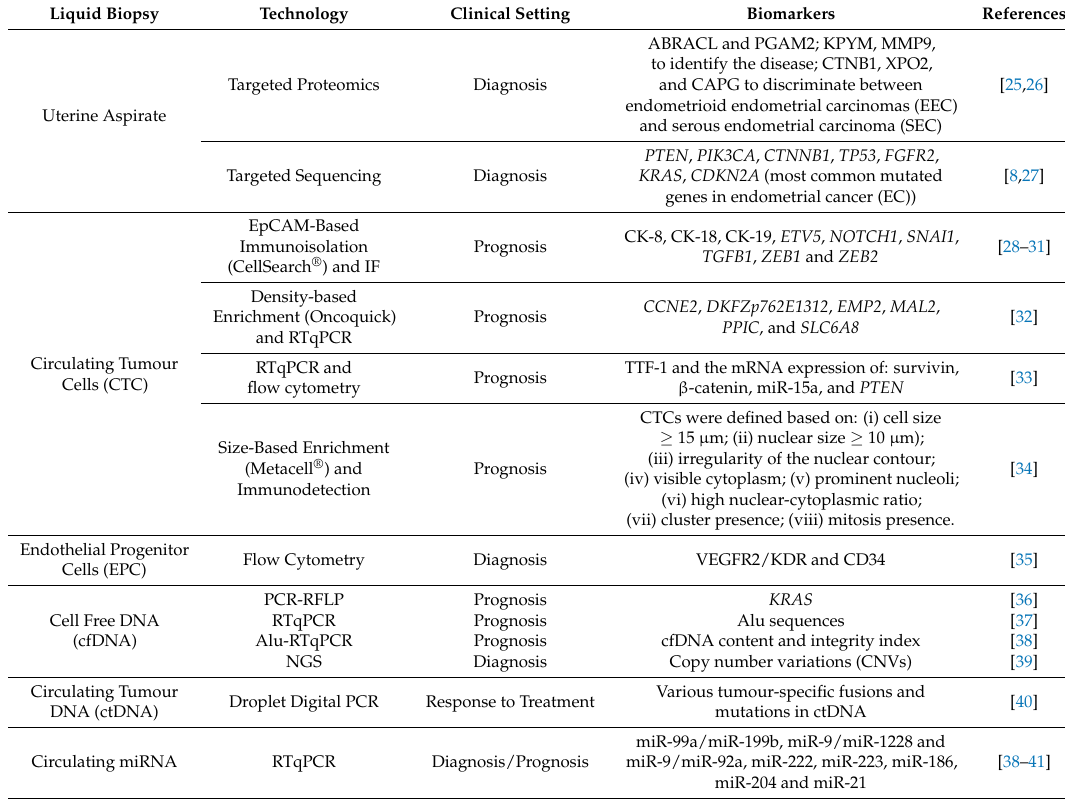
Table 1. Clinical research approaches to liquid biopsy in endometrial